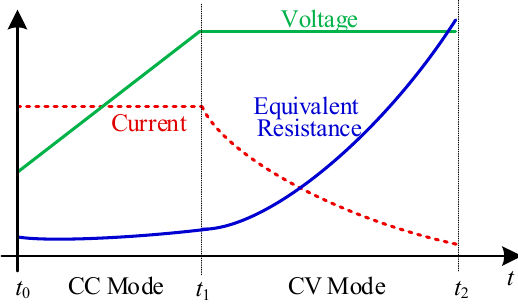
Figure 1. Typical CC-CV charging profile of a battery.